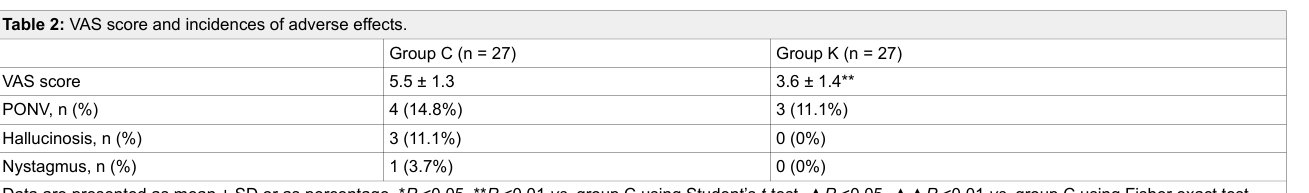
Table 2: VAS score and incidences of adverse